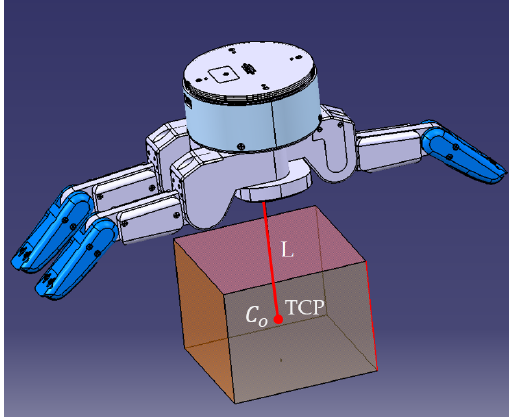
Figure 8. Intersection of TCP and C 0